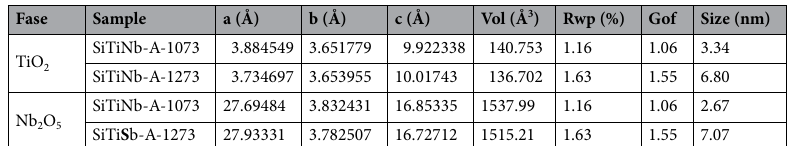
Table 1. Crystallographic data of the SiTiNb-A samples thermally treated at 1073 and 1273 K.